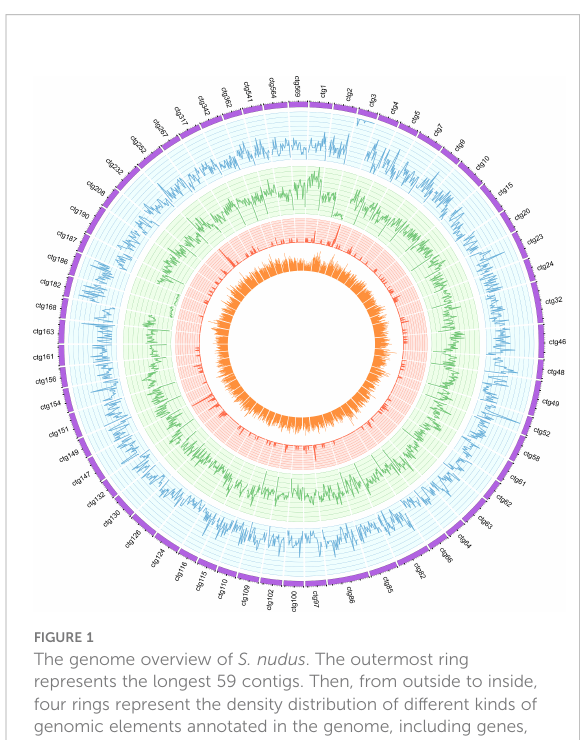
FIGURE 1 The genome overview of S. nudus . The outermost ring represents the longest 59 contigs. Then, from outside to inside, four rings represent the density distribution of different kinds of genomic elements annotated in the genome, including genes, transposons element, non-coding genes, and GC